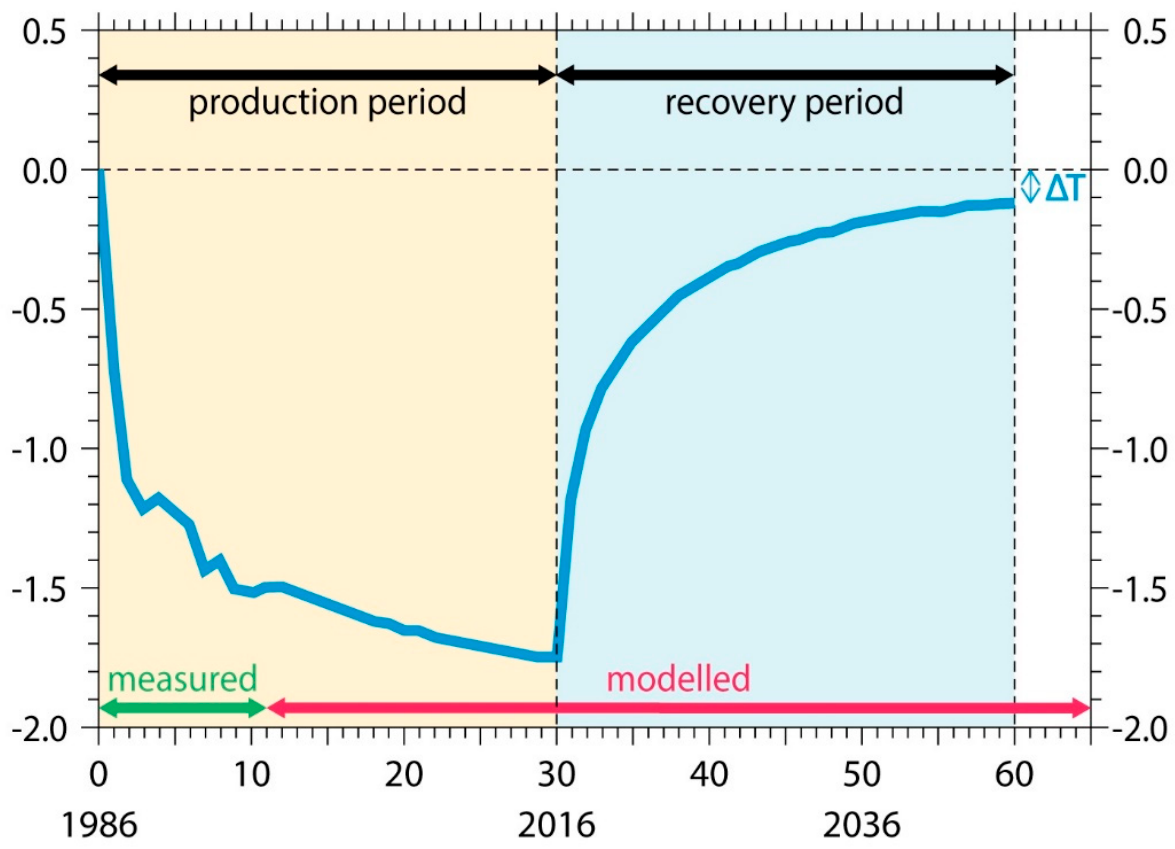
Figure 10. Measured and modeled ground temperature changes at a depth of 50 m and at a distance of 1 m from a 105 m long BHE during a production period and a recovery period of 30 years each. After 30 years of recovery the deficit ( ∆ T) is marginal. The speed/duration of recovery is about the speed/duration of production impact. Data from [9] are plotted.